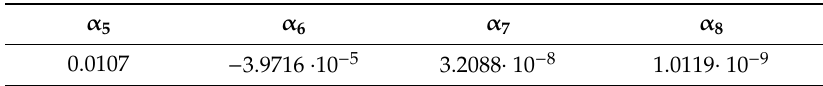
Table 4. Coe ffi cients a i , i = 5 ... 8 of Equation (28) used for the calculation of seawater isobaric heat capacity (Reproduced with permission from [20]. Elsevier,